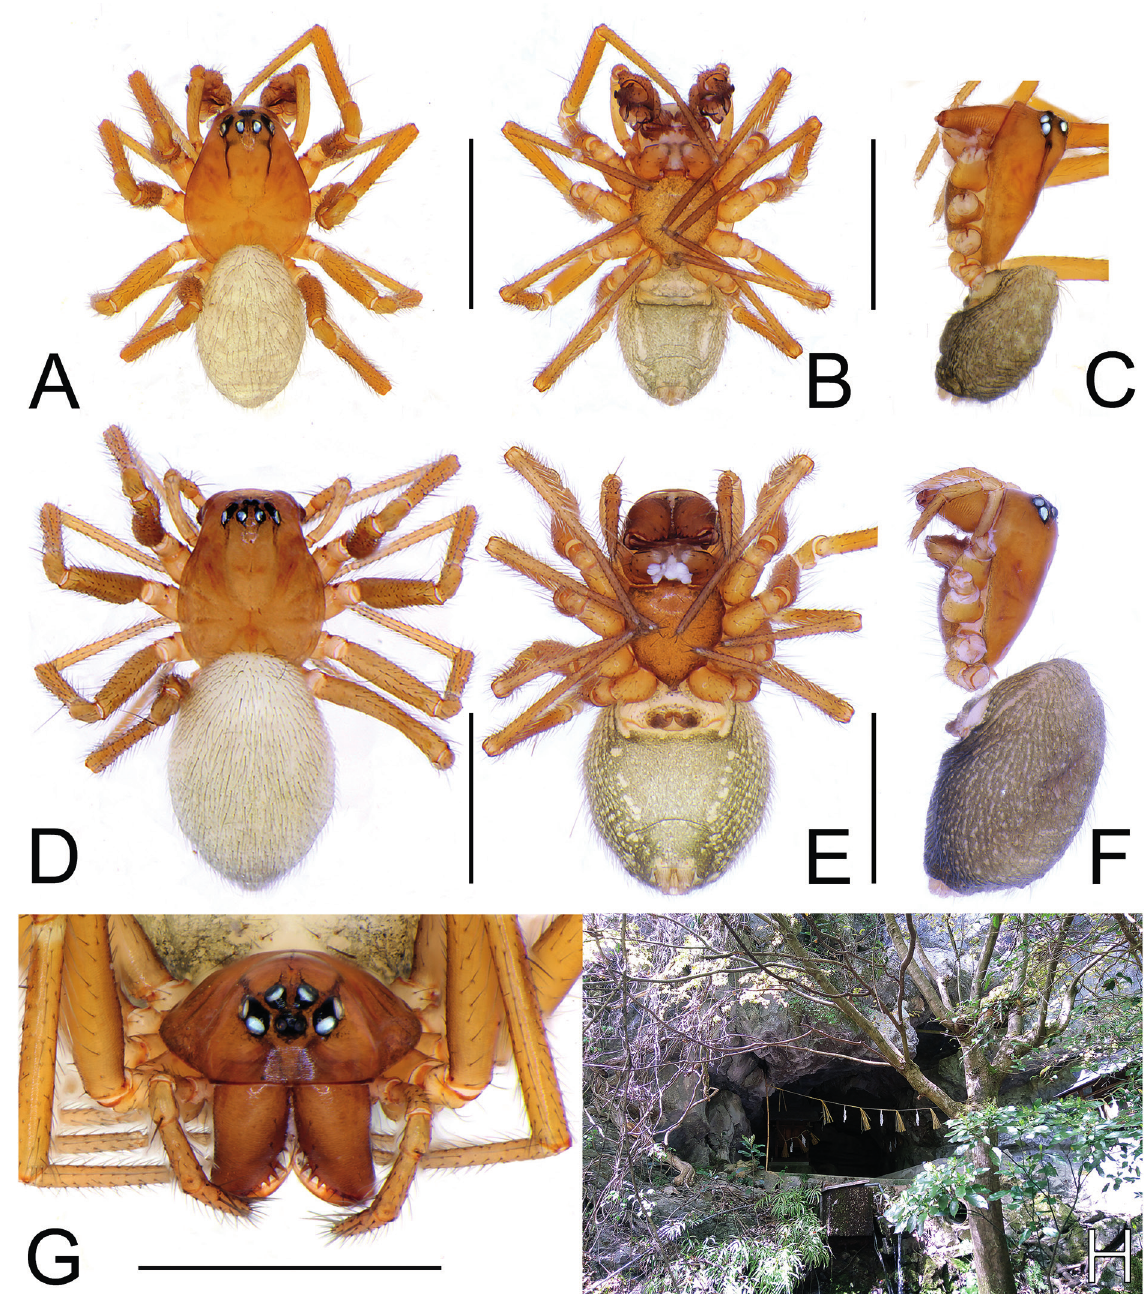
Fig. 1. Habitus and habitat of Nihonella chika gen. et. sp. nov. A . ♂, holotype (NSMT-Ar 20909), habitus, dorsal view. B . Ditto, ventral view. C . Ditto, lateral view. D . ♀, paratype (NSMT-Ar 20910), habitus, dorsal view. E . Ditto, ventral view. F . Ditto, lateral view. G . Ditto, cephalic region, frontal view. H . Entrance of Anatoyama Cave, type locality of the species. Scale bar = 1